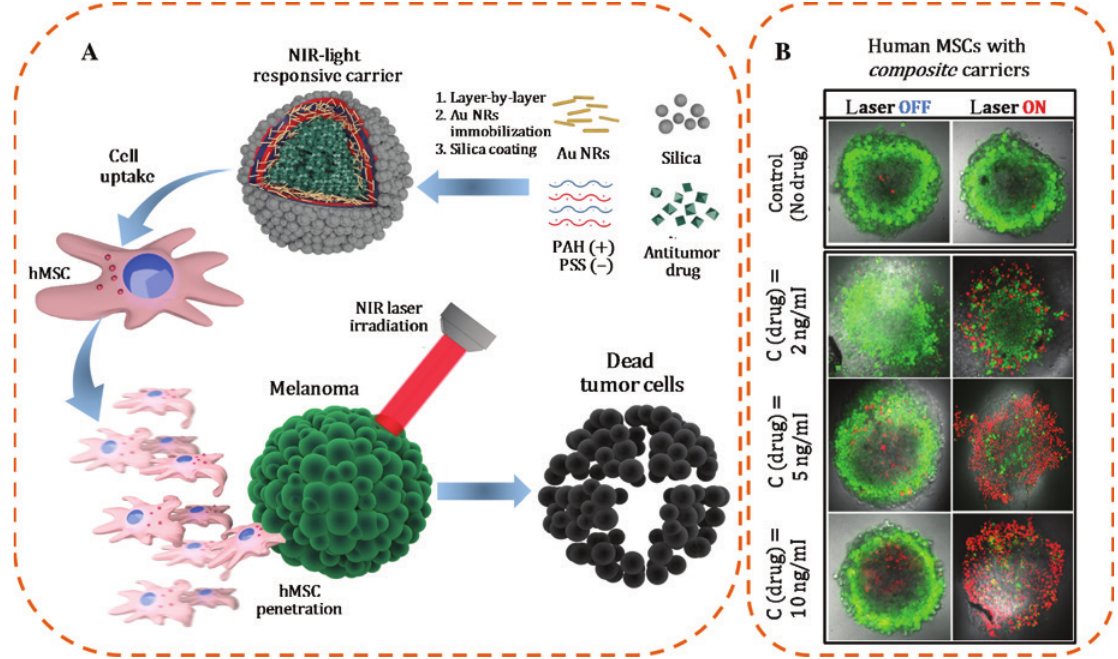
Figure 13: Addressable drug delivery using light-sensitive MSCs-based delivery platform. (A) Schematic diagram of the experimental procedure. (B) Confocal microscopy images of tumour spheroids with and without NIR-laser irradiation incubated with (left) free antitumour drug, (middle) polymer light-sensitive particles loaded with antitumour drug, (right) MSC- modified polymer light-sensitive particles loaded with antitumour drug. Living cells were stained with calcein AM (green); nuclei of dead cells were stained with propidium iodide (red). Scale bars correspond to 100 μ m. Reprinted with permission from [241]. Copyright 2019 Royal Society of